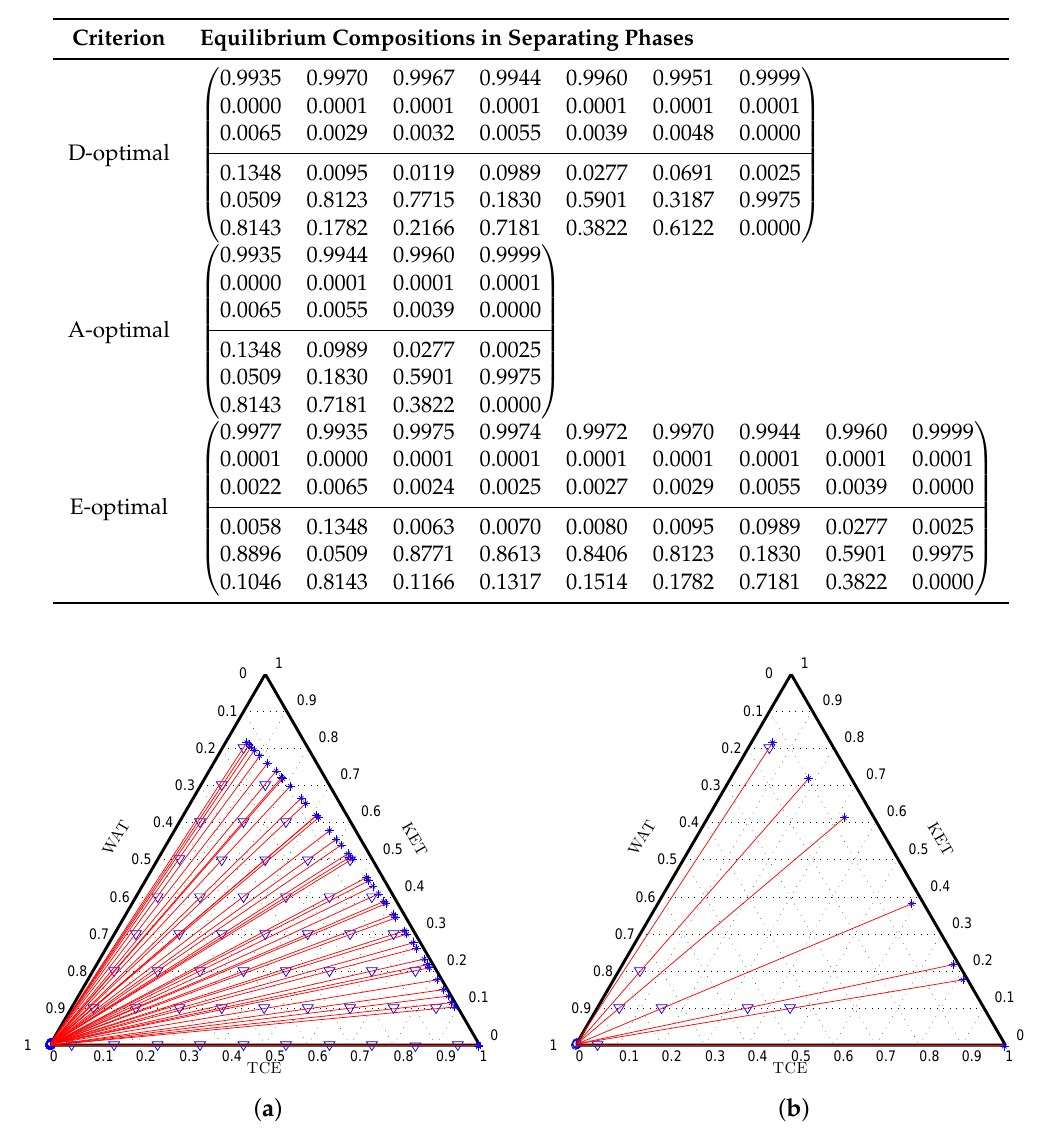
Table 4. Optimal experimental designs for ternary system WAT-TCE–KET (compositions in equilibrium phases).